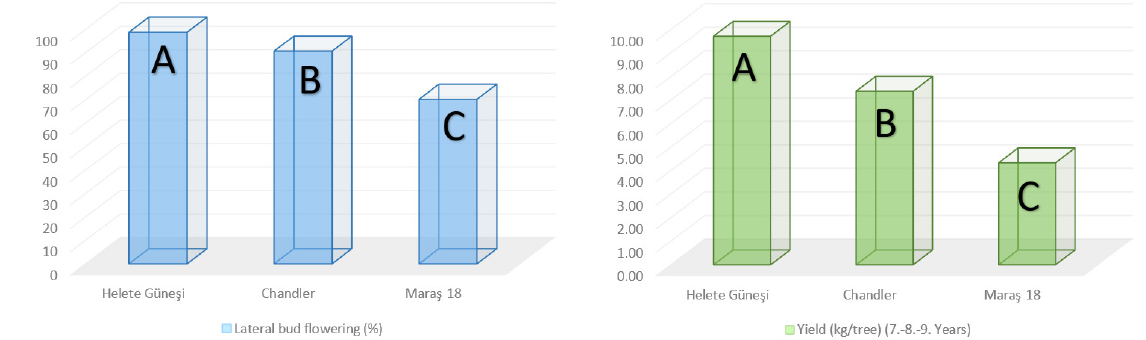
Figure 2. A comparison of three cultivars in terms of yield per tree and lateral bud flowering. Different letters over the columns represent significant differences based on the LSD multiple range test ( p = 0.05).